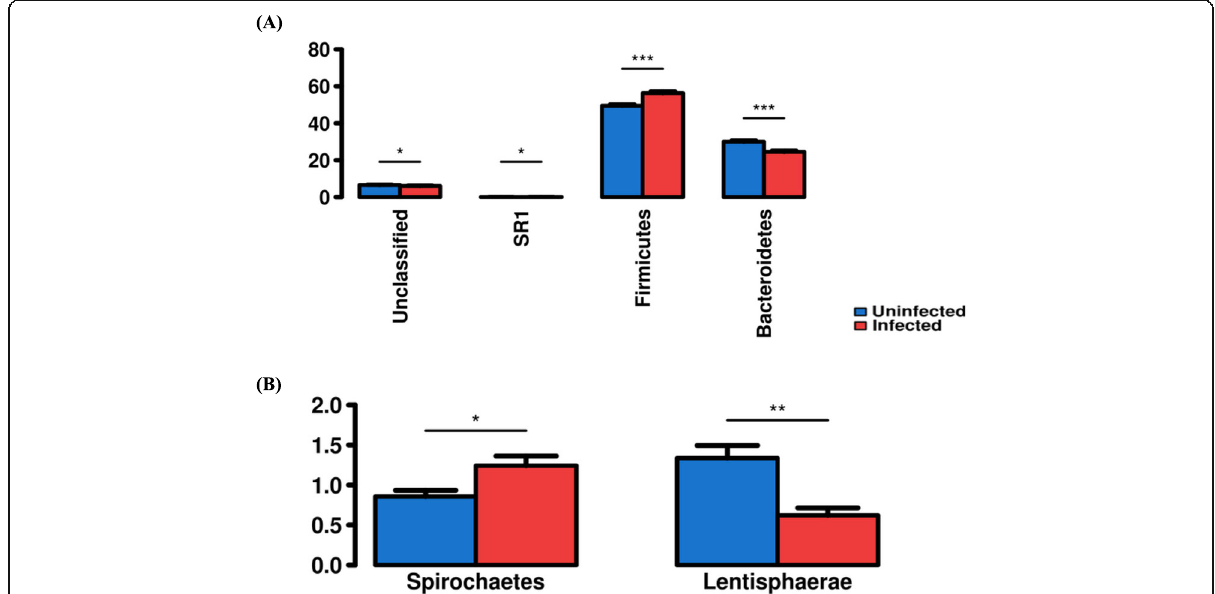
Fig. 6 The bacterial phyla with significant differences in relative abundances before and after infection. ( a ) high-burden; ( b ) low-burden sheep. The Y-axis shows the average relative abundances (%); X-axis shows phyla. Pair-wise comparisons are done by paired t-test. Error bars represent SD. * p ≤ 0.05, ** p ≤ 0.01, *** p ≤